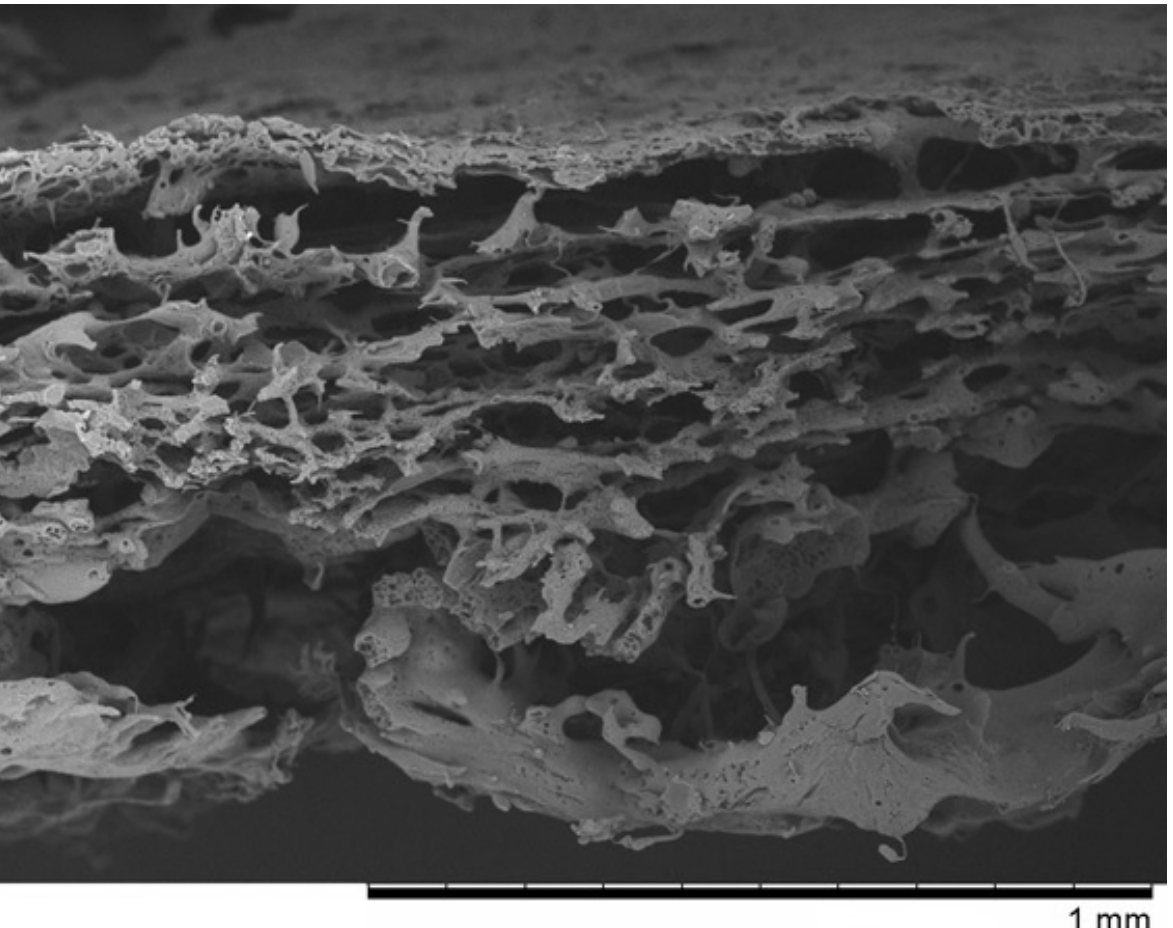
Figure 1. The SEM photomicrographs of the “PVP” membrane.